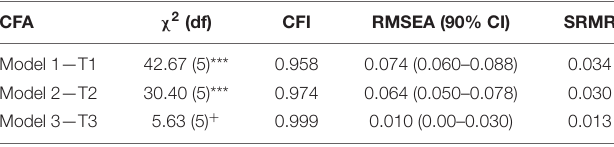
TABLE 1 | Summary of the fit indices for the CFAs of the bullying scales at the three-time point.